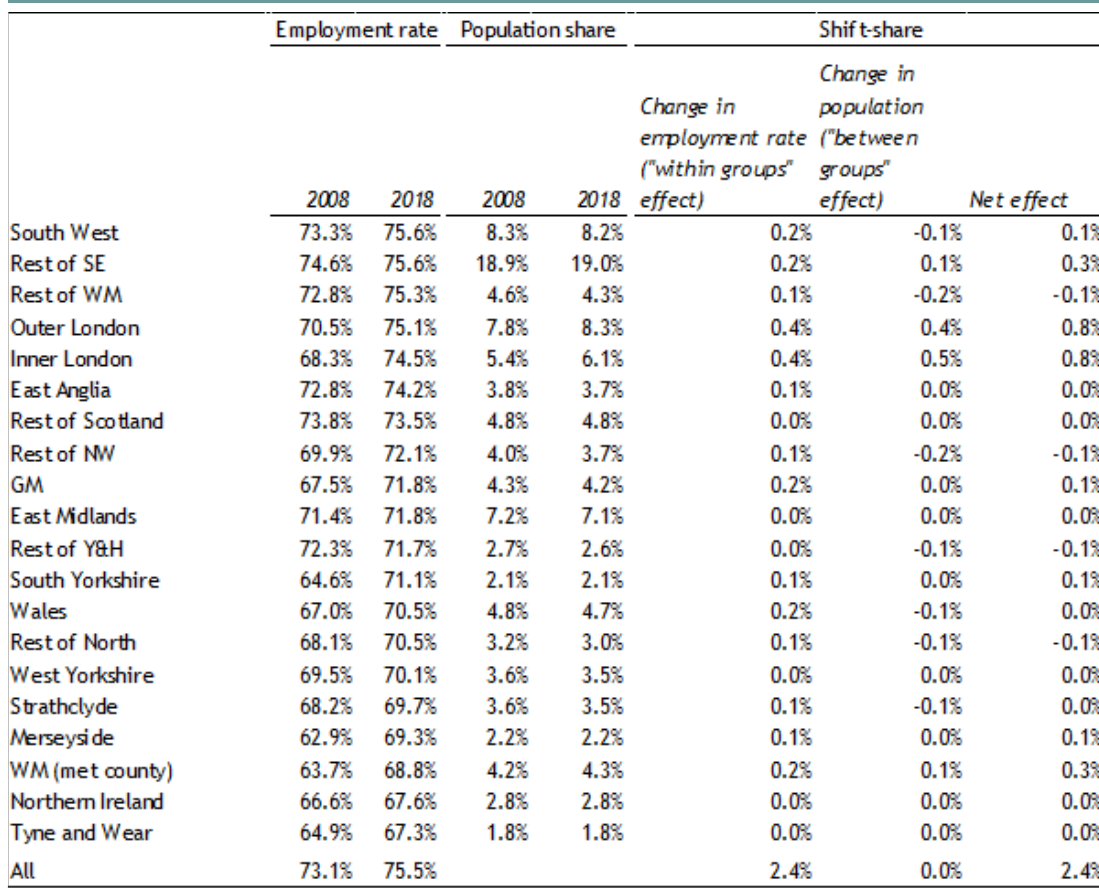
Table 8: Employment and population changes by region, 16-64 year olds: